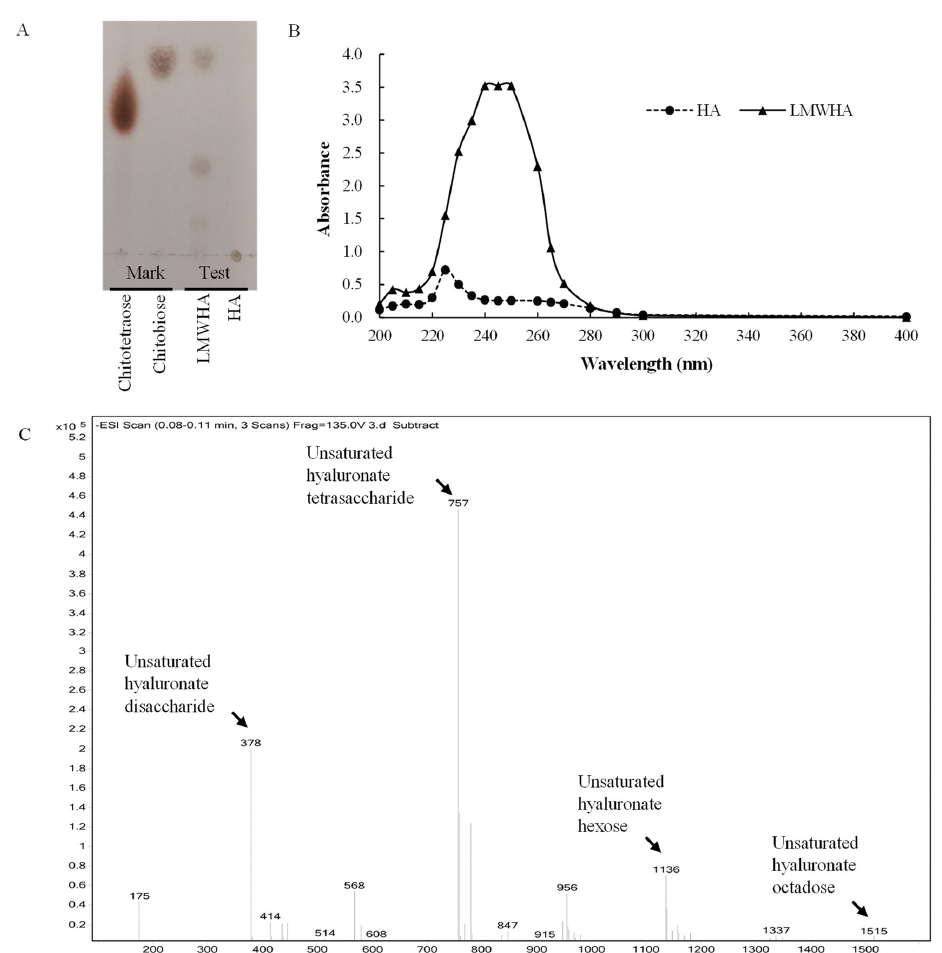
Figure 4. Analysis of the cleavage products of rHynACF8. ( A ) TLC; ( B ) UV–vis absorption spectra; ( C ) ESI-MS.